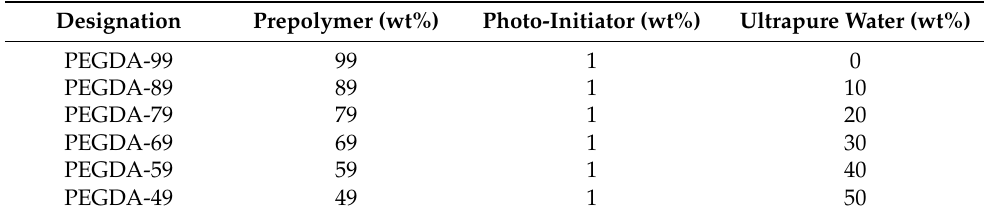
Table 1. The dispersed phase compositions used for the fabrication of PEGDA